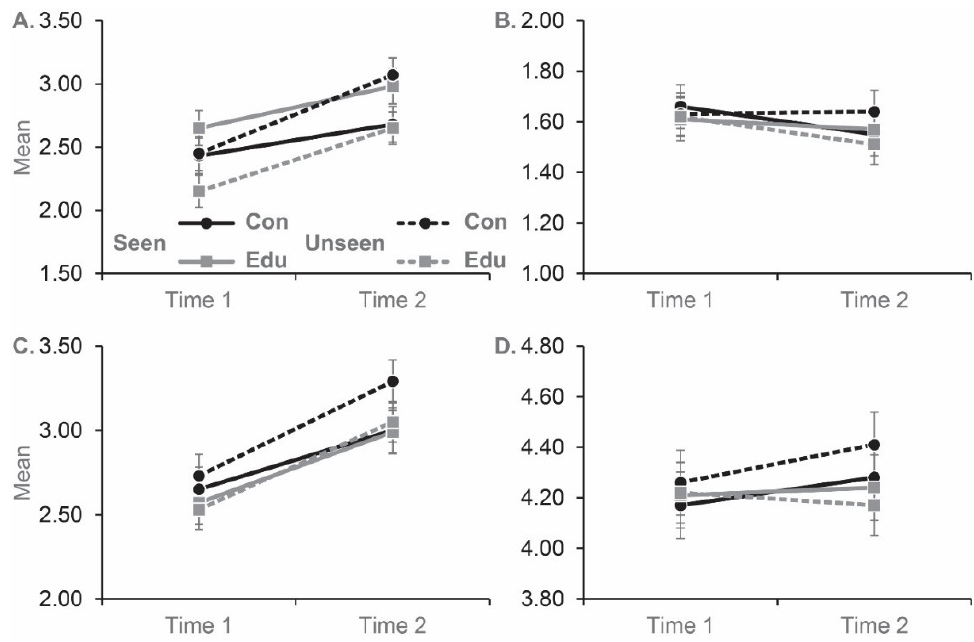
Figure 2. Mean scores for participants in the control (i.e., Joker without educational statements) and education (i.e., Joker with educational statements) conditions on the fear/avoidance ( A ), malevolence ( B ), authoritarianism ( C ) and unpredictability ( D ) subscales of the PPMI. The subscales were com- pleted before (Time 1) and after (Time 2) each film. A total of 80 participants viewed the control version of Joker , and 91 viewed Joker with the educational statements. ‘Seen’ refers to participants that had previously seen Joker , ‘Unseen’ refers to participants that had not previously seen Joker . Error bars represent ± standard error of the mean.